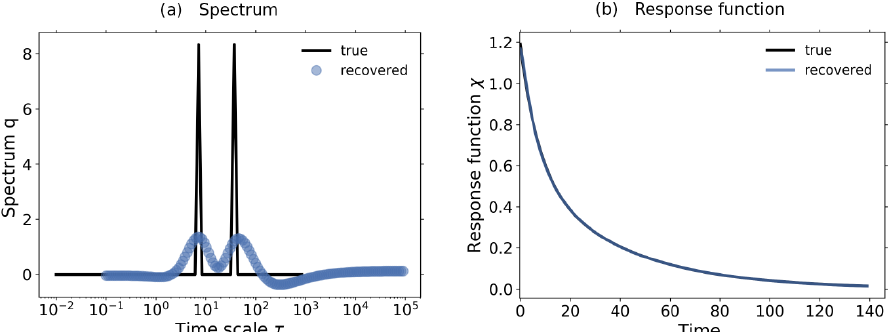
Figure E3. Spectrum q λ and response function χ(t) recovered from a 1% experiment performed with the toy model described in Part 1 taking an underlying discrete spectrum with two timescales τ = 7 and τ = 37. The data were taken with SNR ∼ O ( 10 4 ) − O ( 10 5 ) .